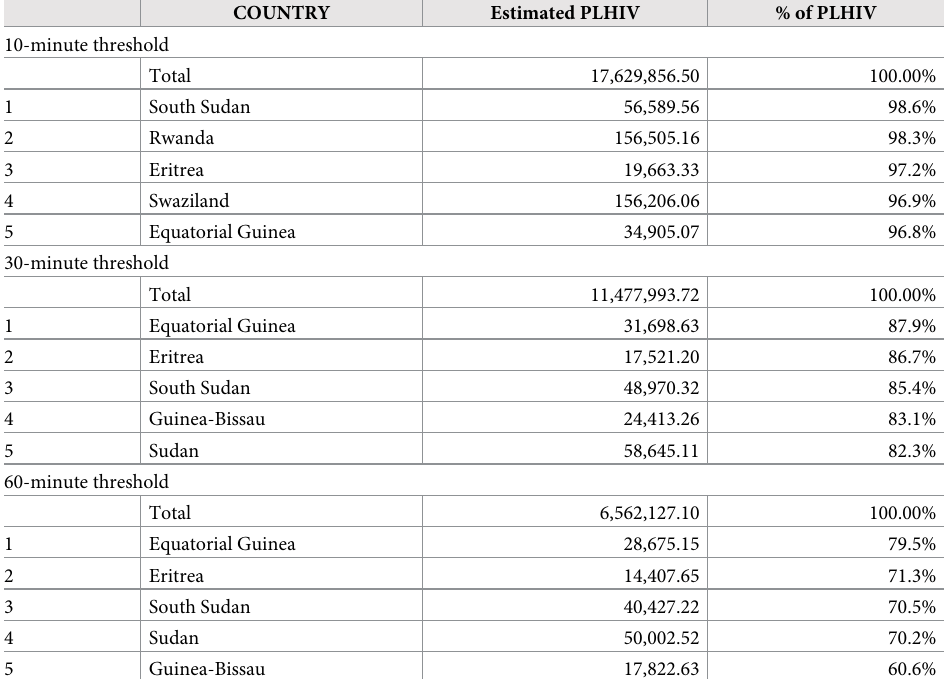
Table 2. The top five countries in sub-Saharan Africa with the highest number (%) of People Living with HIV (PLHIV) who cannot access health care facilities within thresholds by non-motorized transportation in 2017. COUNTRY Estimated PLHIV % of